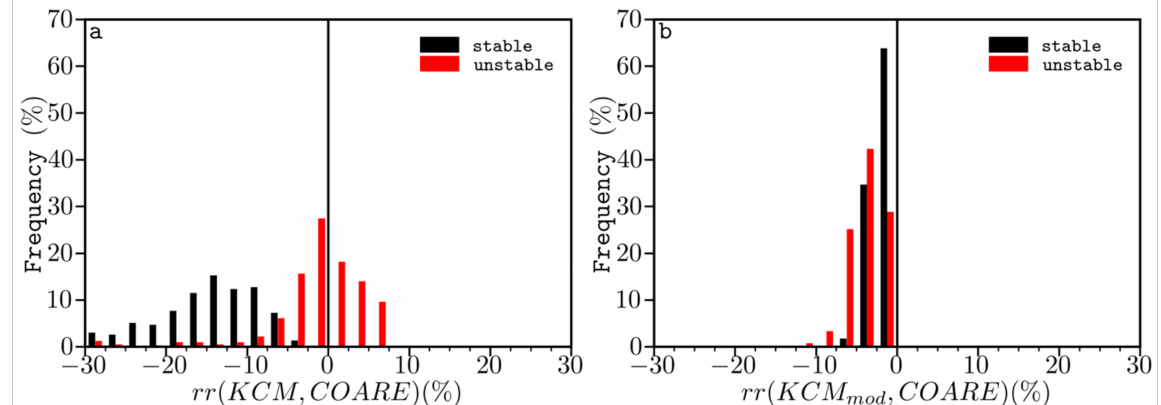
Figure 6. ( a ) Frequency distribution (%) of the symmetrically normalized relative residuals of simulated surface friction velocity u ∗ with KCM and COARE algorithms, rr = (COARE-KCM)/ (COARE KCM) 1/2 . The data are divided based on the bulk atmospheric stability; black (red) bars represent samples under near-neutral to stable (near-neutral to unstable) conditions. ( b ) As in Figure 6a, but for the modified version KCM mod